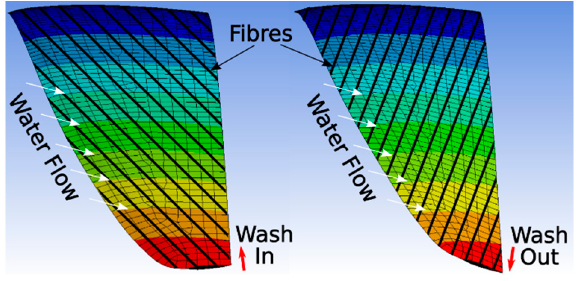
Figure 22. Fibre alignment for wash-in and wash-out (pressure, i.e., leeward side). The influence of rotations of the full-face outer plies, 2 and 3, and 4 and 5, as those with